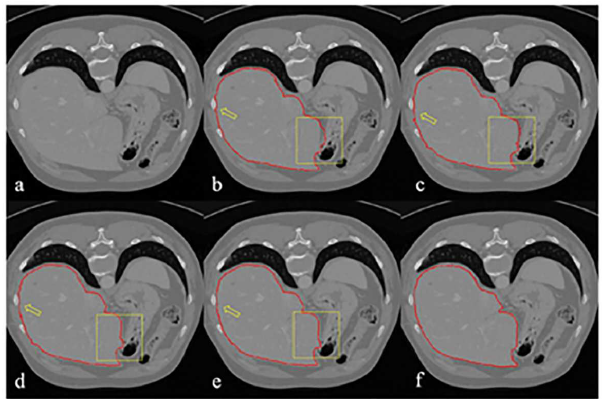
Fig 4. Segmentation results with different β